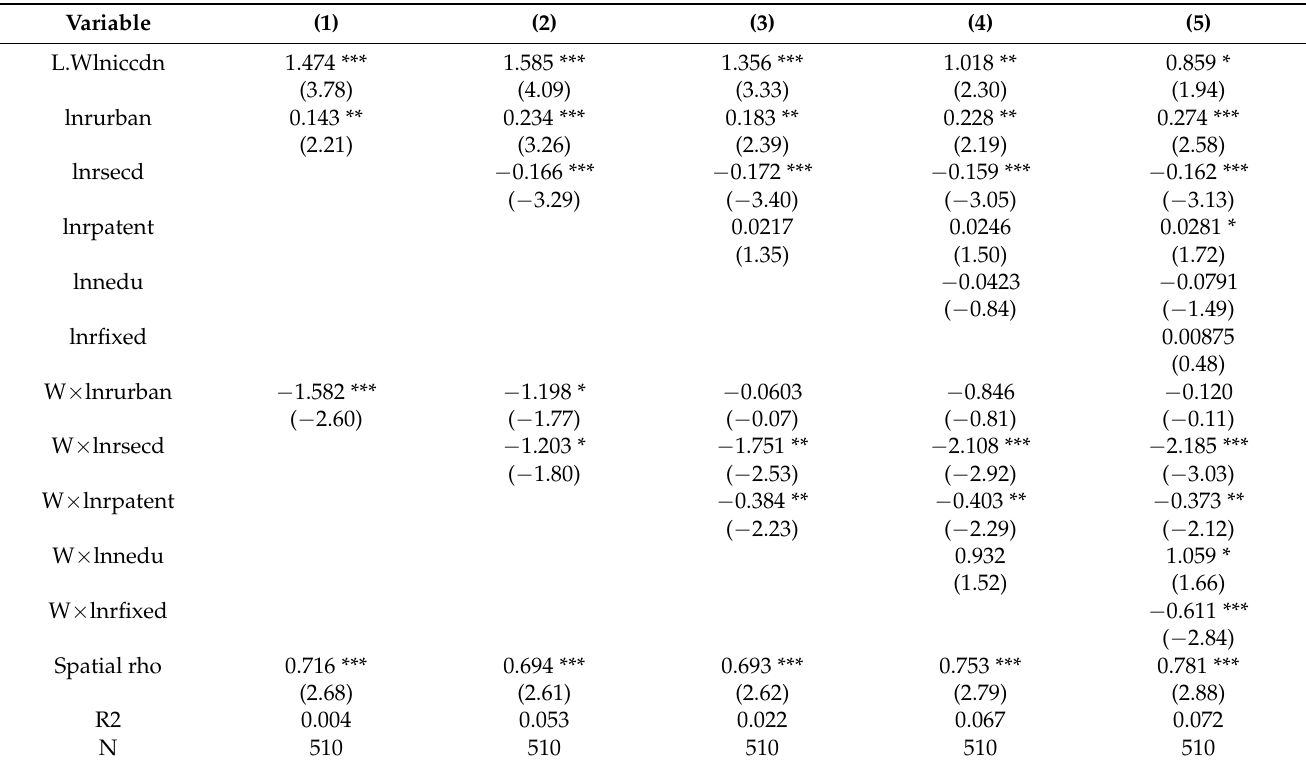
Table 5. The estimation results of the benchmark